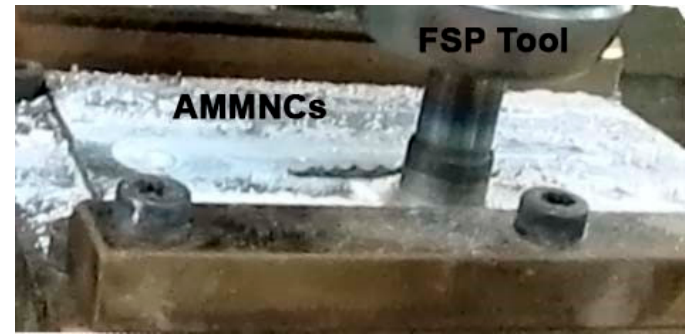
Figure 1. Friction Stir Processing (FSP) using vertical milling machine with fixture installation.